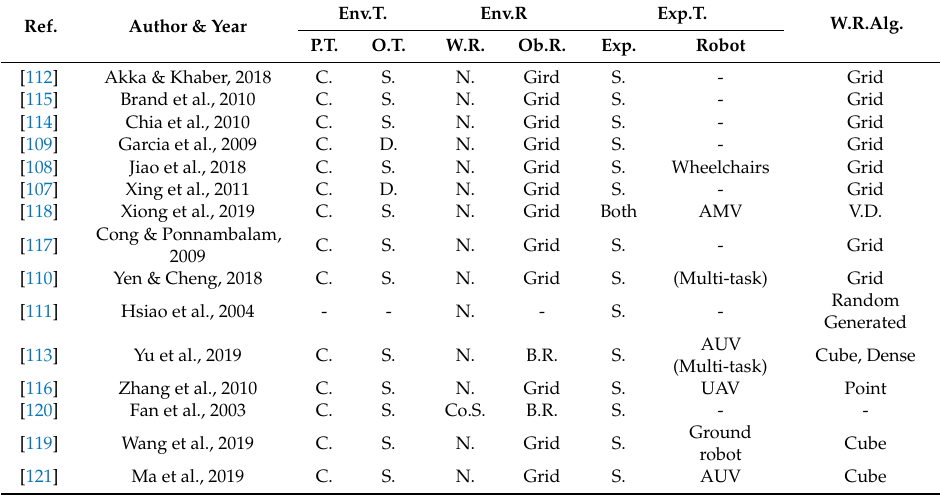
Table 7. Classification of the paper using the heuristic-based algorithm (ant colony optimization (ACO)).